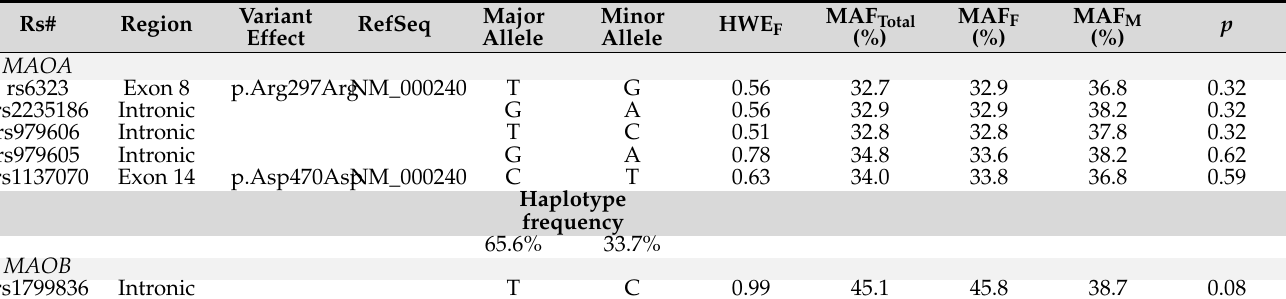
Table 2. Genomic and haplotypic information of the 6 selected MAOA and MAOB